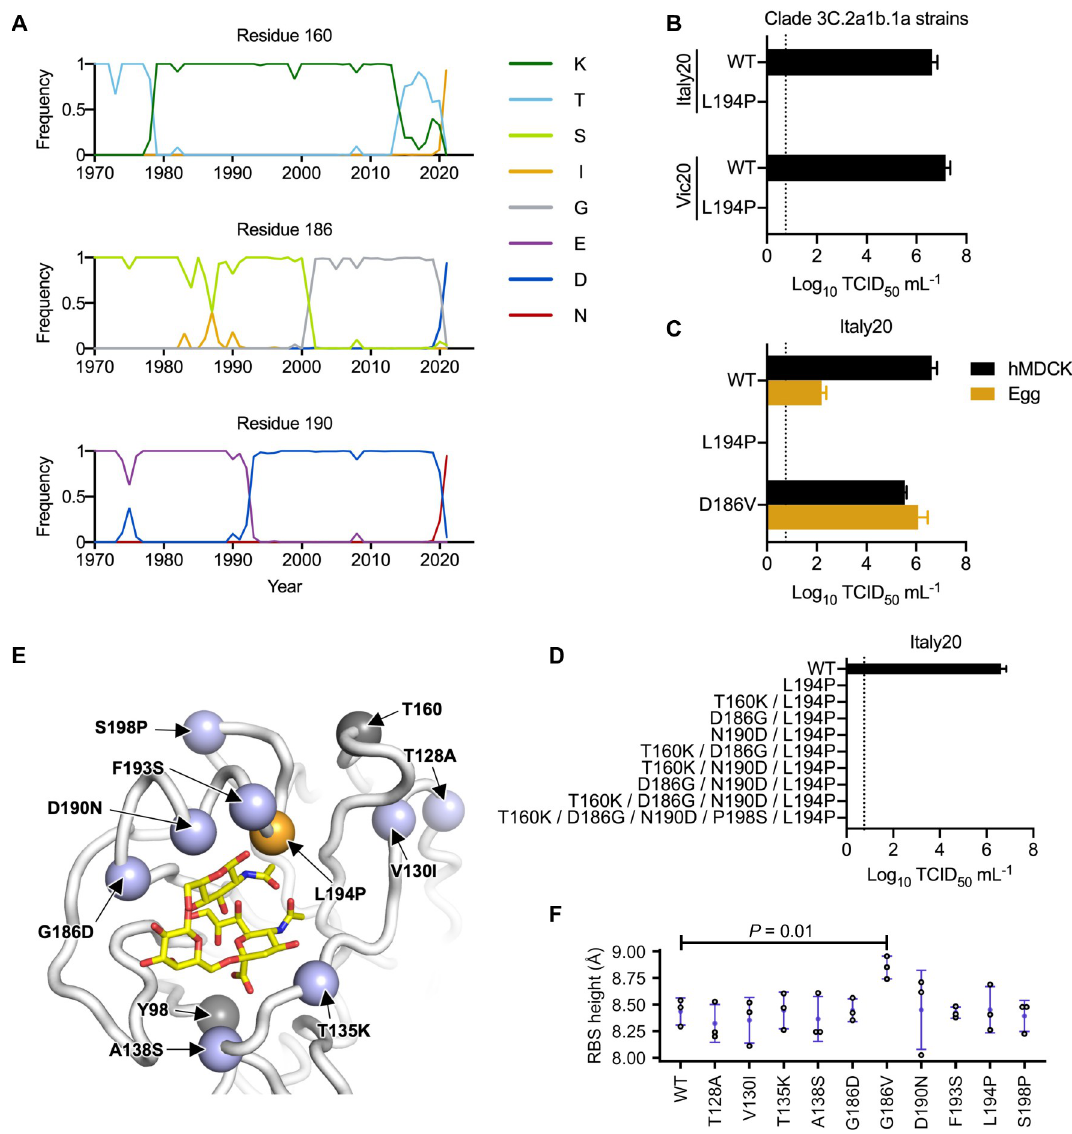
Fig 3. Incompatibility between N190 and P194. (A) Frequencies of amino acid variants at residues 160, 186 and 190 in human H3N2 HA over time are shown. Only those variants that reached a maximum annual frequency of 35% are plotted. (B) Two wild type (WT) strains in clade 3C.2a1b.1a (Vic20 and Italy20) with or without L194P mutation were examined in a virus rescue experiment in mammalian cells (293T/hMDCK). Of note, most unpassaged strains in clade 3C.2a1b.1a, including both Vic20 and Italy20, naturally contain N190. (C) The replication fitness of Italy20 with indicated mutations was examined in a virus rescue experiment in mammalian cells (293T/hMDCK) as well as in an egg-passaging experiment, in which 10 4 TCID 50 of the rescued viruses were propagated in eggs for 48 hours. (D) The replication fitness of Italy20 with indicated mutations was measured in a virus rescue experiment in mammalian cells (293T/hMDCK). (B-D) Viral titers were measured by TCID 50 . The means of three independent experiments are shown with SD indicated by the error bars. The dashed line represents the lower detection limit. (E) The locations of mutations between Sing16 and Italy20 in the receptor-binding subdomain (residues 117–265) [21] are shown in blue (PDB 6BKT). The locations of T160 and Y98 are shown in grey [17]. L194P is in orange. Sialylated glycan receptor is in yellow sticks representation. (F) The structural impact of each mutation was modeled by Rosetta [48]. The distance between the phenolic oxygen of Tyr98 (OH 98 ) and the C α of residue 190 was computed as the height of receptor-binding site (RBS). Three replicates, each with 100 simulations, were performed. Each data point represents the lowest scoring pose in a replicate. Error bars represent the SD. P -value was computed by two-tailed t-test. Only the difference between WT and G186V is statistically significant ( P < 0.05).